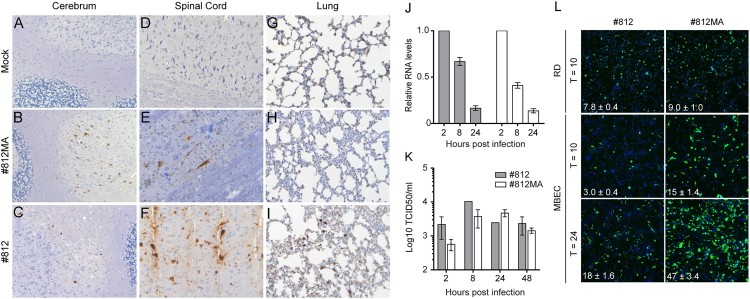
EV-A71 infects (motor)neurons and type II pneumocytes. EV-A71 antigen expression in SCID mouse tissue. Mice were either mock infected or infected with EV-A71 #812MA or EV-A71 #812 and sacrificed when paralysis was first observed. Paraffin embedded, formalin fixed tissue sections were stained with an anti-EV-A71 antibody. Representative pictures of (A-C) cerebrum, (D-F) spinal cord and (G-I) lungs. (J-K) Infection of bone-marrow-derived macrophages. Cells were differentiated in M-CSF-containing medium for 6 days and infected with #812 and #812MA (MOI = 1). At selected times p.i., cells were harvested. Infection was quantified by RT-qPCR (J) and TCID50 determination on RD cells (K). (L) MBEC and RD cells were infected with EV-A71 #812 or EV-A71 #812MA for 1 h. Following fresh medium replacement, the cells were further incubated for the indicated times. After fixation, the infected or mock cells were stained by dsRNA antibody, followed by high-content imaging counting. Images shown are representative fluorescent micrographs. The data shown are mean ± SEM of one (J-K) or two (L) independent experiments each containing three (J-K) to six (L) biological replicates.